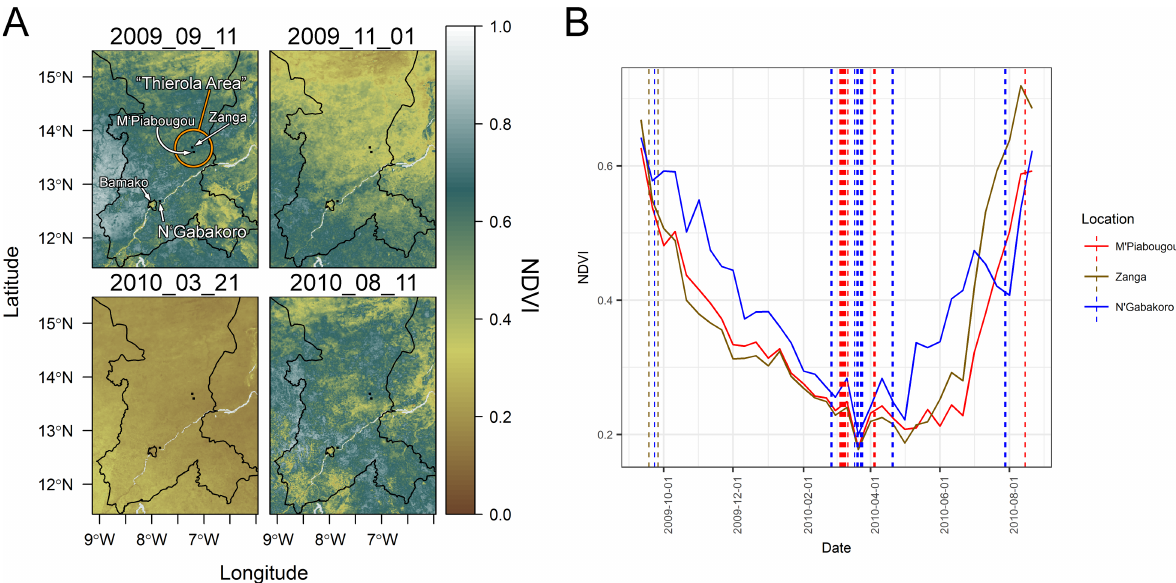
Fig 1. Sampling locations in the Koulikoro region of Mali overlaid over seasonal normalized difference vegetation index data (panel A) and at each location throughout the sampling period (panel B). NDVI measures the greenness (vegetation) level of an area measured from a satellite. The villages of M’Piabougou and Zanga in the area of Thierola with higher seasonality and lower water availability are compared to N’Gabakoro, a village near Bamako and the Niger River using this metric. Examples of wet season (top left, bottom right of panel A), transitional (top right of panel A), and dry season (bottom left panel A) are presented. Microbial sampling dates per village are marked with vertical dashed lines (panel B).